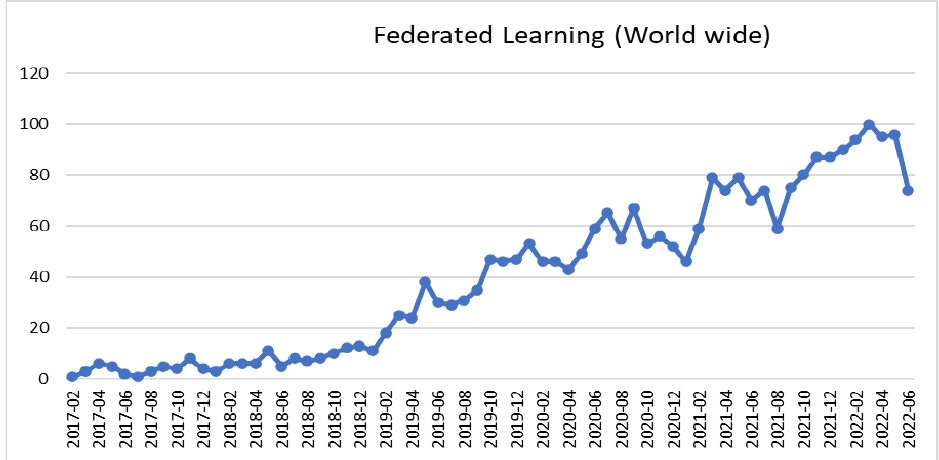
Figure 2. FL between 2016 and 2022 (Google Trends).